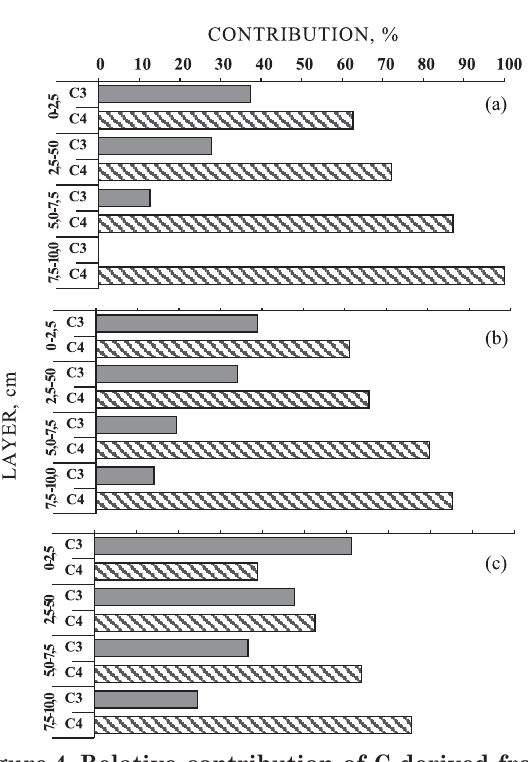
Figure 4. Relative contribution of C derived from ) and from trees (C ) in the 0–10 cm pasture (C 4 3 soil layer under guachapele (a), eucalyptus (b) and mixed plantations (c).